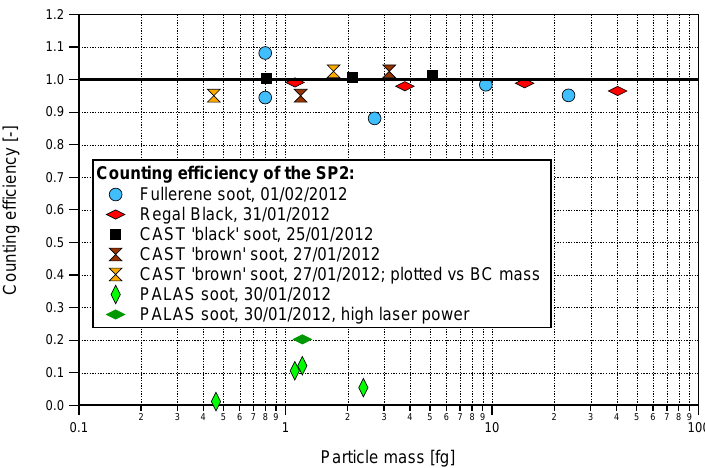
Fig. 3. Counting efficiency of SP2’s incandescence detector relative to CPC for different soot samples as a function of particle mass de- termined by the APM. The CAST “brown” soot is additionally shown as a function of the mean BC mass per particle determined by the